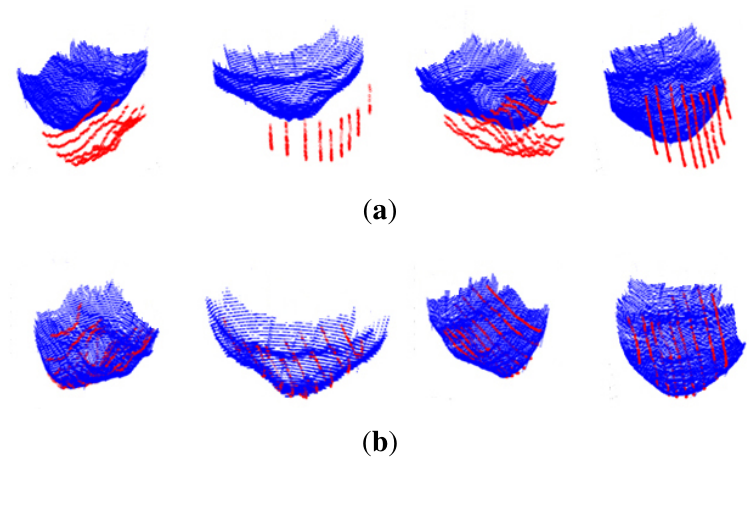
Figure 19. Registration results: ( a ) before registration; and ( b ) after